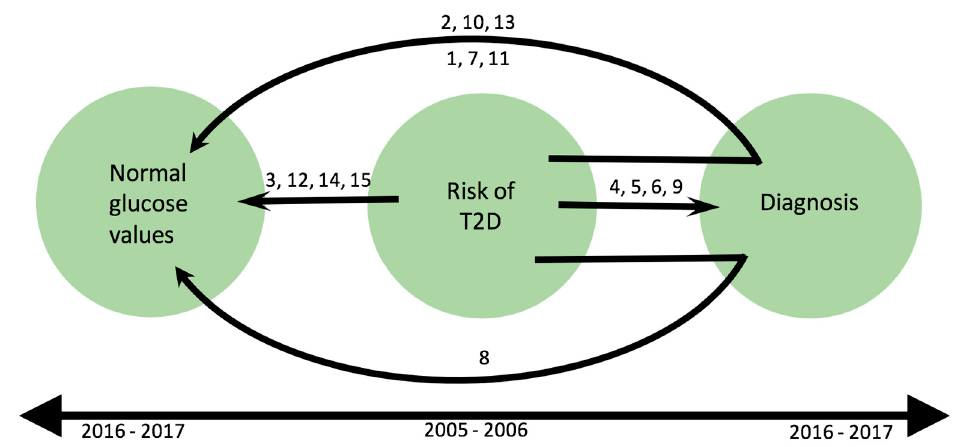
Figure 2. Graphical illustration of T2D risk in the 15 study participants over time. (Each number 1–15 represents a participant.